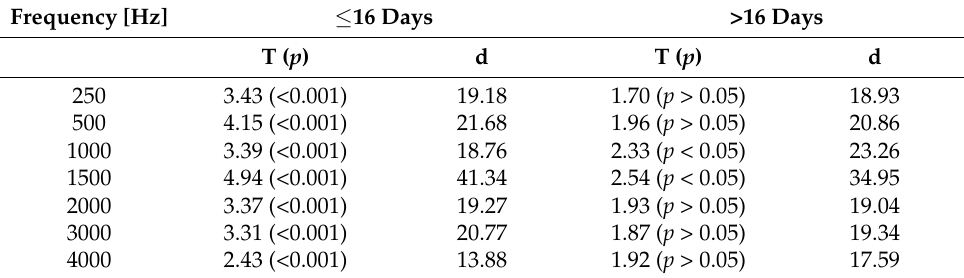
Table 5. Duration of steroid therapy and improvement of